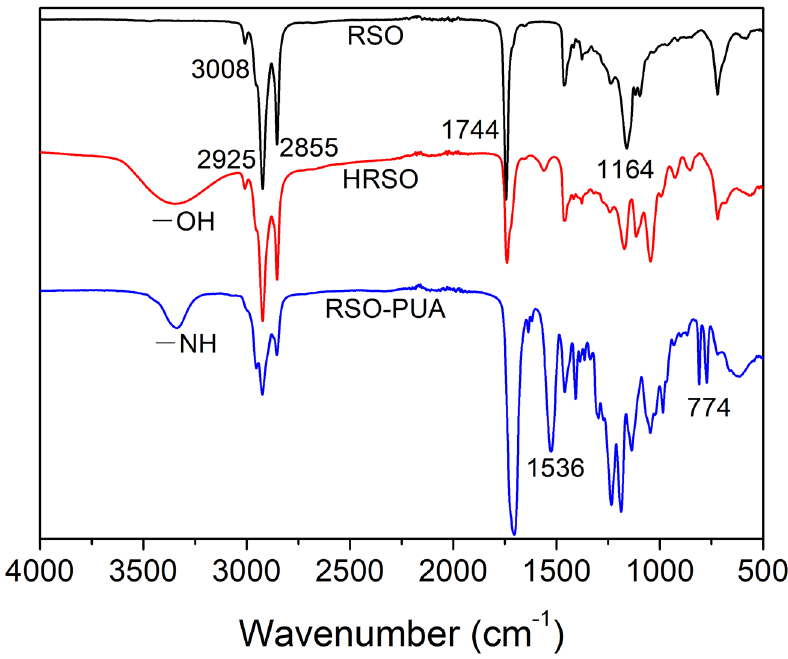
Figure 1. FT-IR spectra of RSO, HRSO and RSO-PUA.